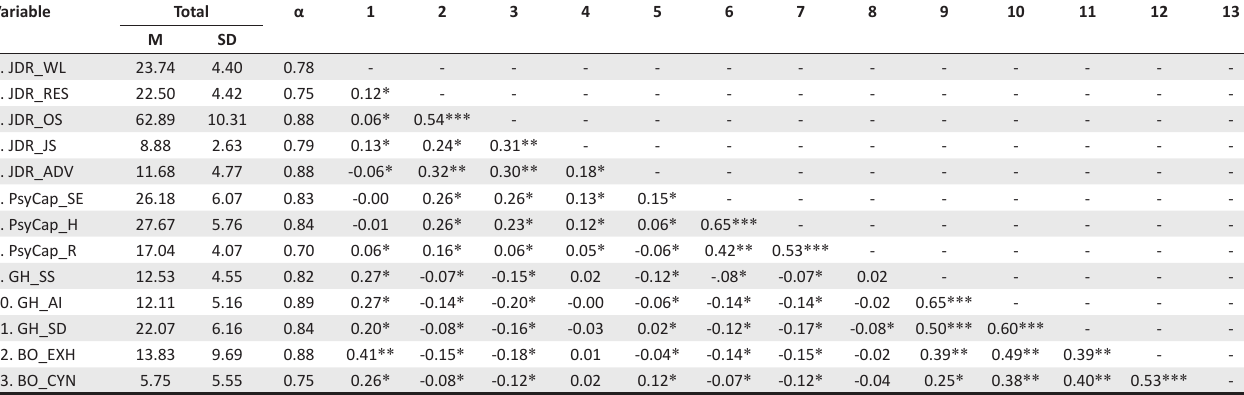
TABLE 2: Mean, standard deviation, Cronbach’s alpha and Pearson product-moment correlation. Variable